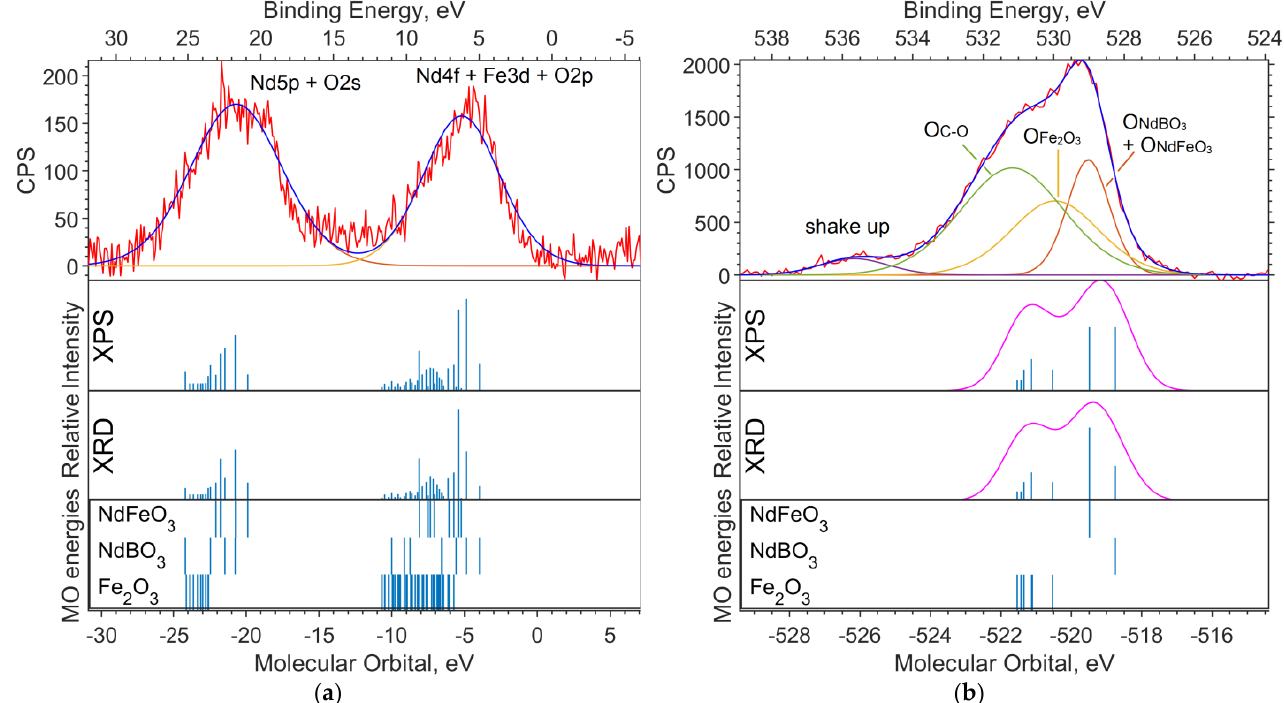
Figure 2. ( a ) XPS spectrum of the valence region and ( b ) spectrum of oxygen 1s levels for the NdFe (1 − x) Co x B oxide powders with x = 0. The Gaussian functions with a half-width FWMH = 1.5 eV are superimposed on the theoretical intensities on ( b ).